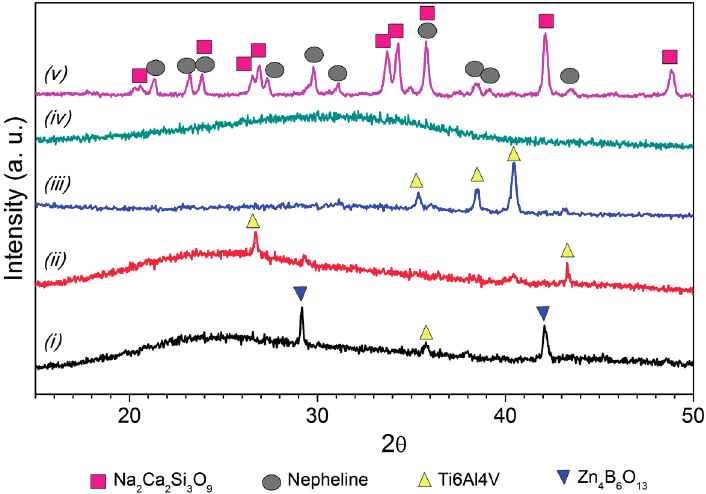
Figure 4. XRD patterns of the top surface of the coatings on Ti6Al4V substrate for: (i) ZnO15 heated in air; (ii) ZnO15 heated in argon; (iii) ZnO35 heated in air; (iv) ZnO35 heated in argon; and (v) G3 heated in